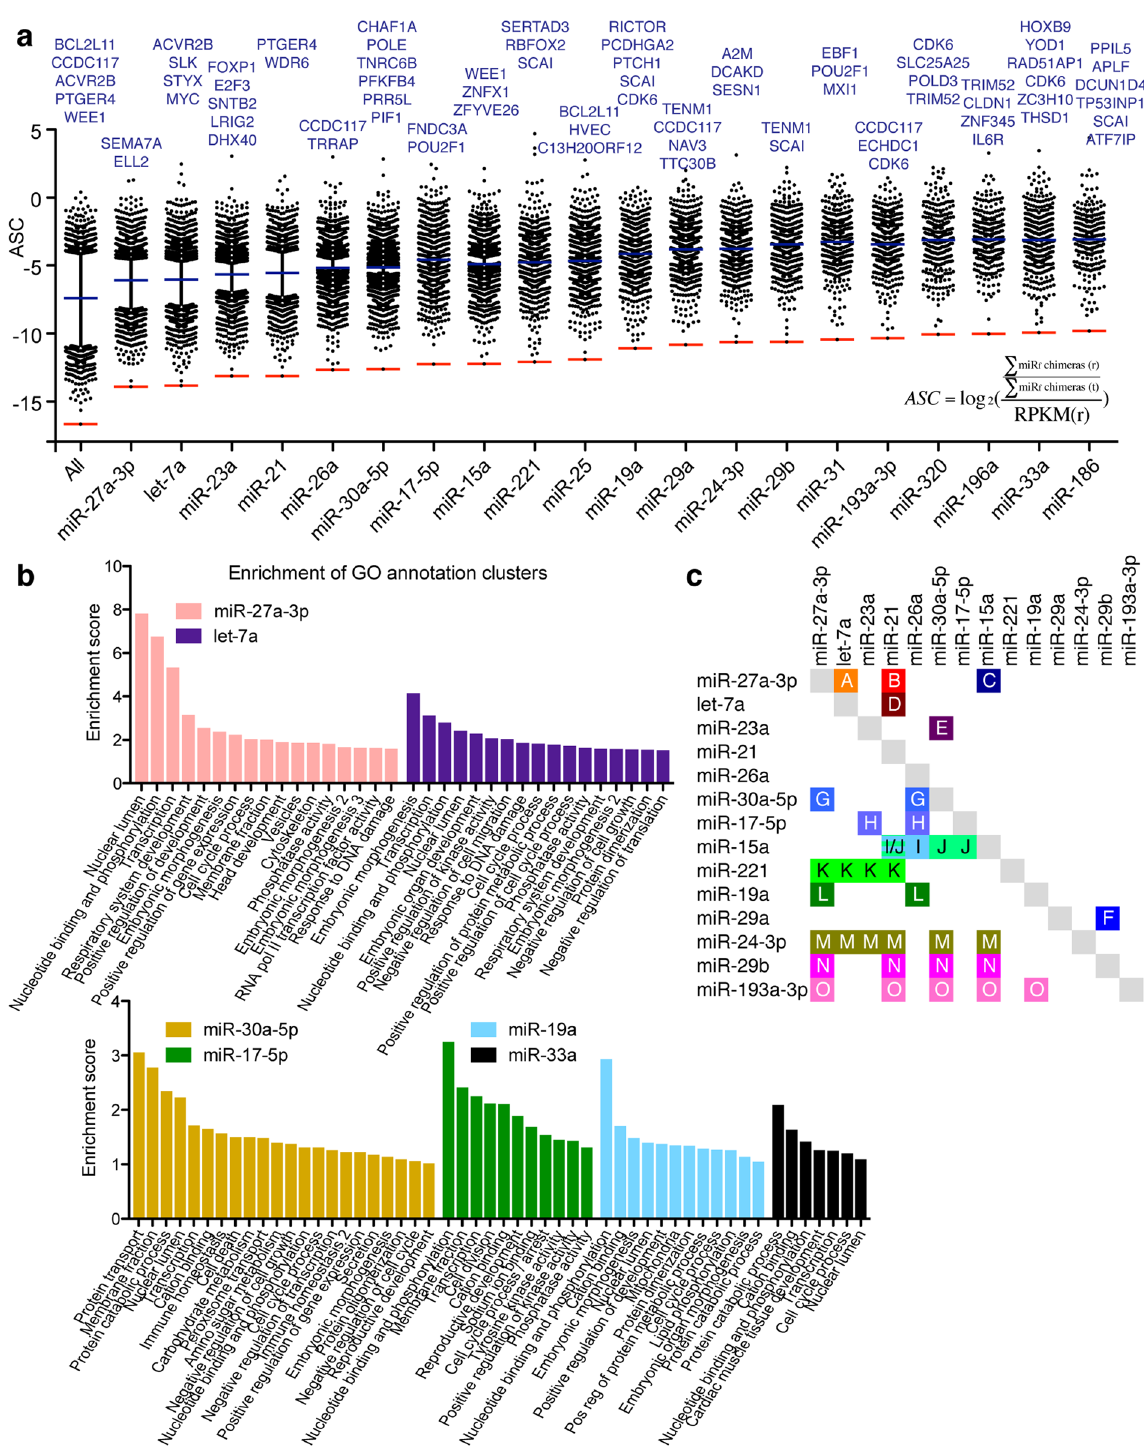
Figure 5. Gene targeting profile for the most abundant miRNAs. (a) ASC values are plotted for the most abundant miRNA families. The most highly targeted mRNAs are noted. Blue lines indicate mean values (excluding non-targeted mRNAs); red lines indicate lower level of quantification. In the calculation of ASC values, f denotes the miRNA family of interest, r the mRNA in question and t total number. (b) GO analysis on gene sets with high ASC values for selected miRNA families. Enrichment scores of annotation clusters are shown. (c) Cooperativity of miRNA families in mRNA targeting. Pairwise (upper right) or multi-family (lower left) miRNA family targeting cooperatives are highlighted. Color-coding and letter designation refers to k-means clusters of genes by miRNA specific ASC values (refer to Figure S5b–d). Highlighted groups occurred in all three iterations of analysis, except for groups C, I and K that occurred in only